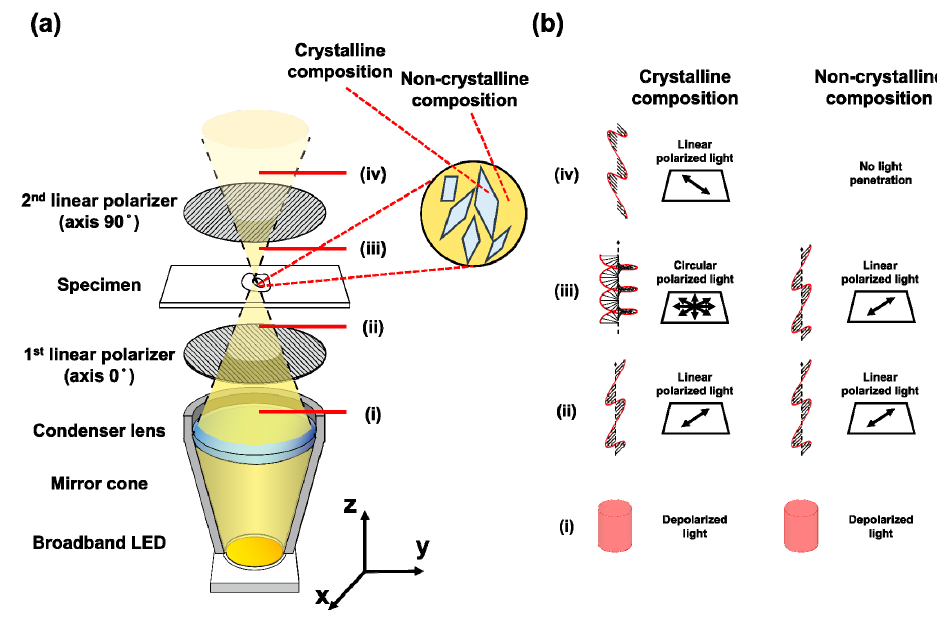
Figure 1. The ( a ) schematic and ( b ) principle of a polarization microscopy system. (i) space between the first polarized and condenser lens; (ii) space between the specimen and the first polarizer; (iii) space between the second polarizer and specimen; (iv) space between the aperture of the microscope and the second polarizer. LED = light-emitting diode.